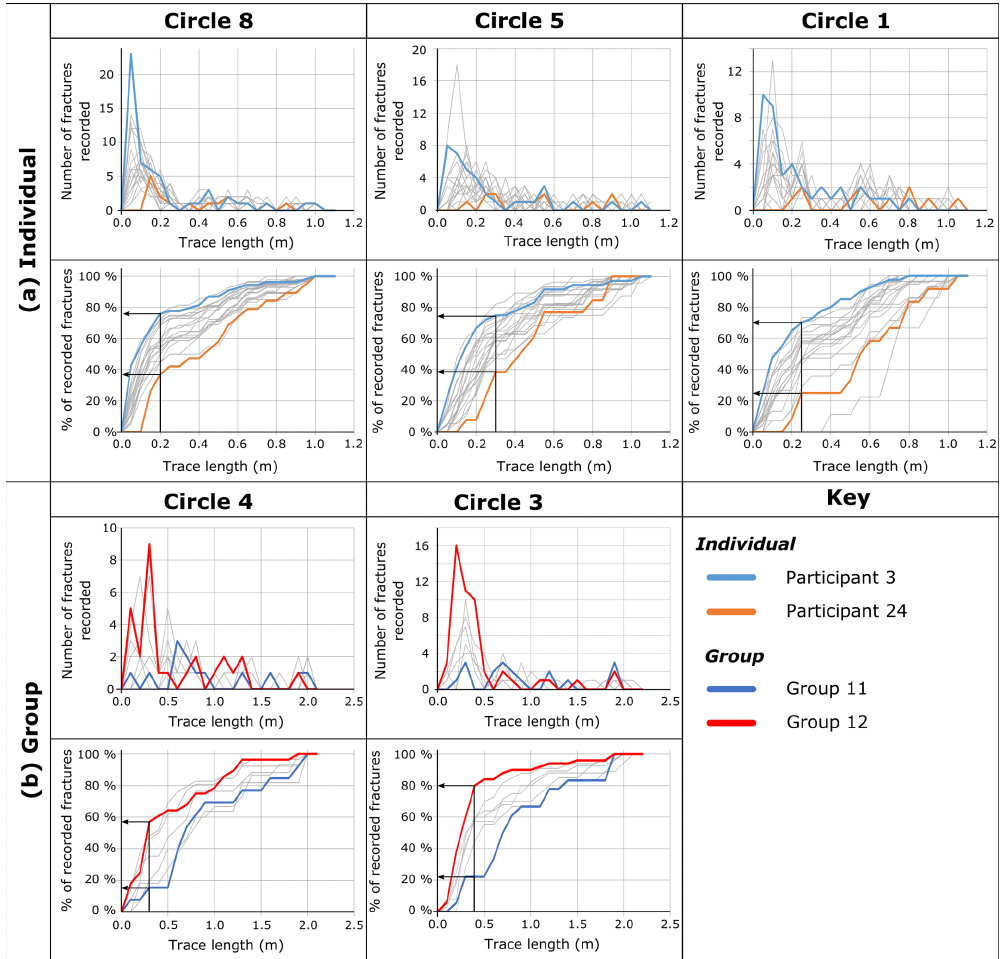
Figure 6. Fracture trace length distributions for (a) individual and (b) group window sampling data. The results are presented as both histograms and normalised cumulative frequency curves of fracture trace length with bin widths of 0.05m for individual and 0.1m for group window sampling data. The range in the relative percentage of small fractures observed in the data is highlighted using participants and groups who consistently observed a high and low percentage of small fractures (Participants 3 and 24 and Groups 12 and 11,